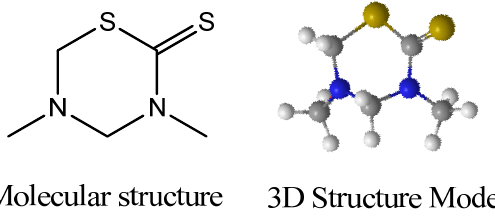
Figure 1. The 3,5-dimethyltetrahydro-2 H -1,3,5-thiadiazine-2-thione scaffold.